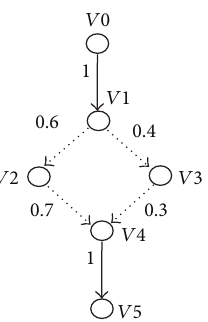
Figure 9: A directed graph for the object movement.